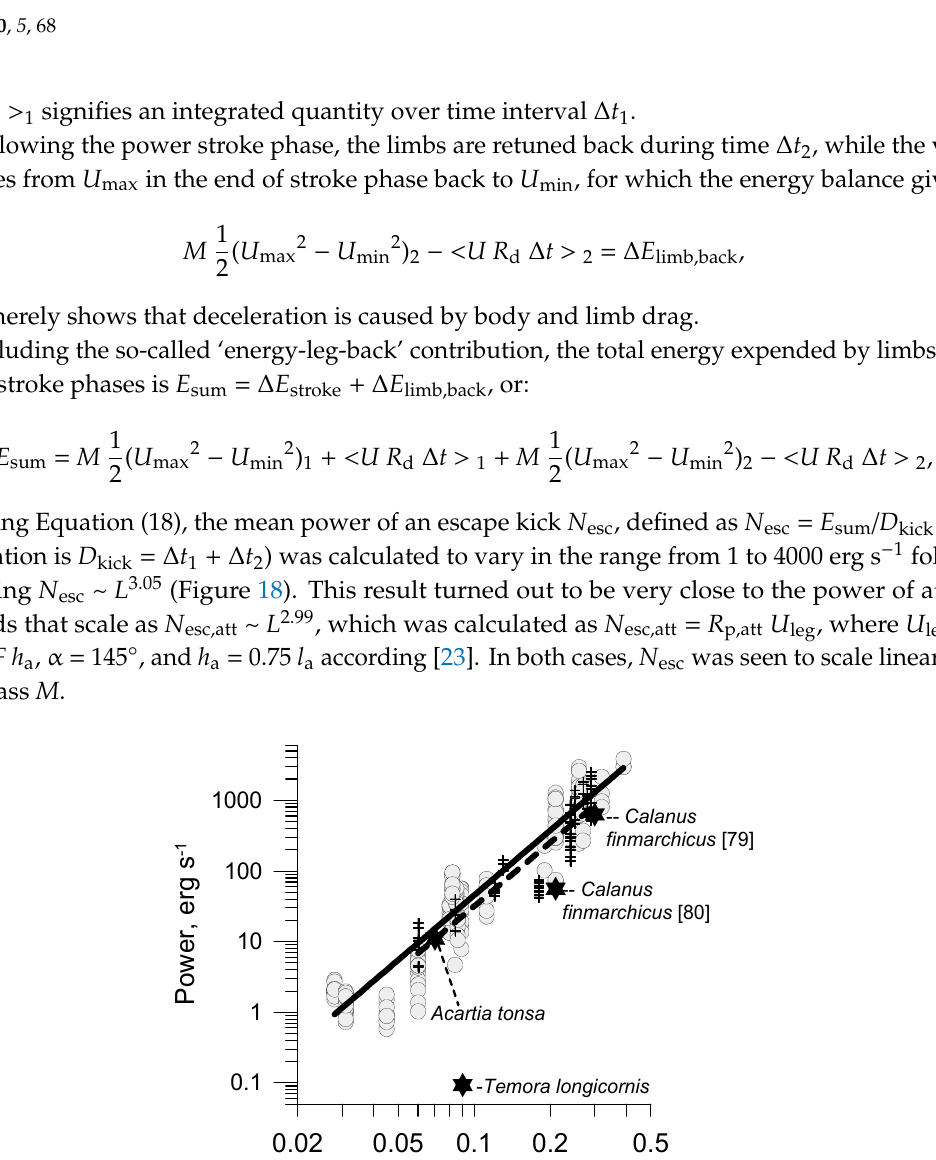
) and attached ( + ) (cid:35)